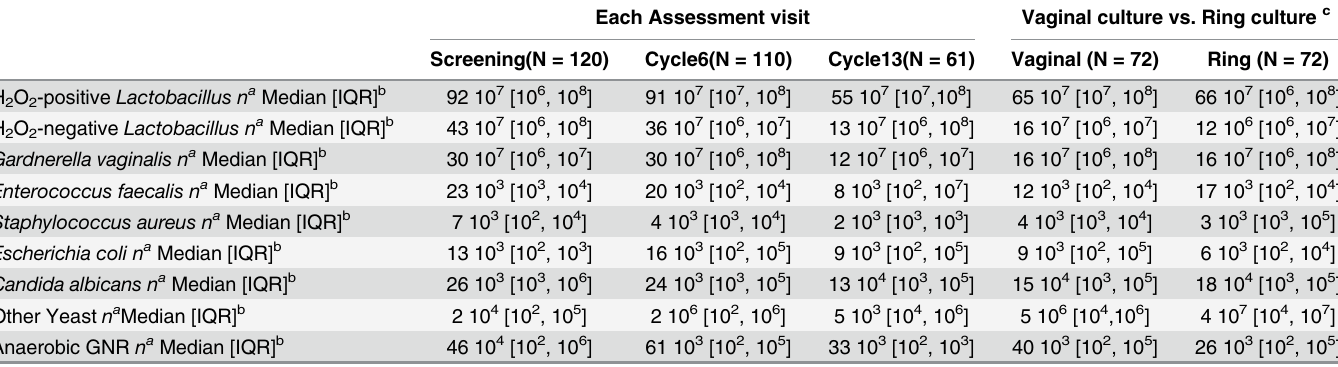
Table 3. Median concentration (cfu/gm) of selected vaginal microbiota at each assessment window and for ring culture among positive